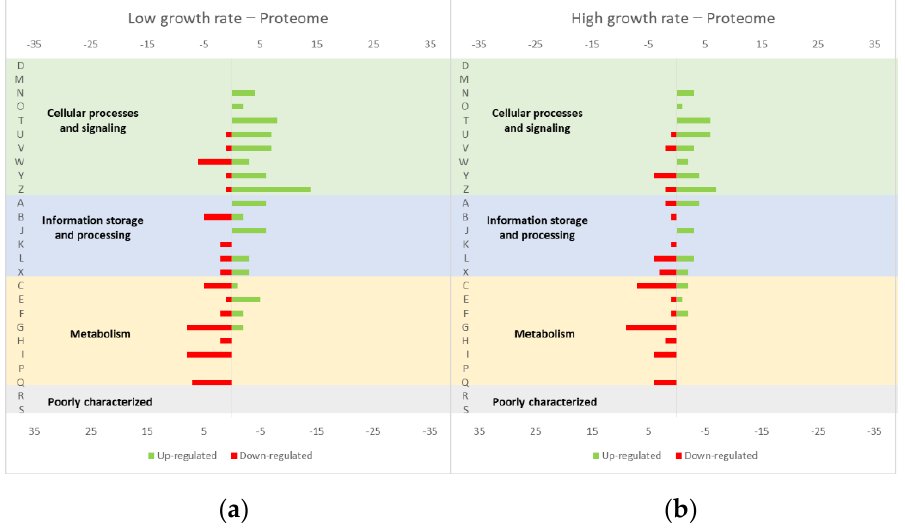
Figure 6. Effect of the growth rate in the L. lactis proteome profile: ( a ) low growth rate (0.24 h −1 ) versus ( b ) high growth rate (0.47 h −1 ). The graphs were constructed with compiled data from Dressaire et al. [40] and represent the total number of transcripts up or down-regulated in each cellular process. The letters on the yy axis correspond to the following COG categories: A, RNA processing and modification (not used for prokaryotic COGs), B, chromatin structure and dynamics, C, energy production and conversion, D, cell cycle control and mitosis, E, amino acid metabolism and transport, F, nucleotide metabolism and transport, G, carbohydrate metabolism and transport, H, coenzyme metabolism, I, lipid metabolism, J, translation, K, transcription, L, replication and repair, M, cell wall/membrane/envelope biogenesis, N, Cell motility, O, post-translational modification, protein turnover, chaperone functions, P, Inorganic ion transport and metabolism, Q, second- ary metabolites biosynthesis, transport and catabolism, T, signal transduction, U, intracellular traf-